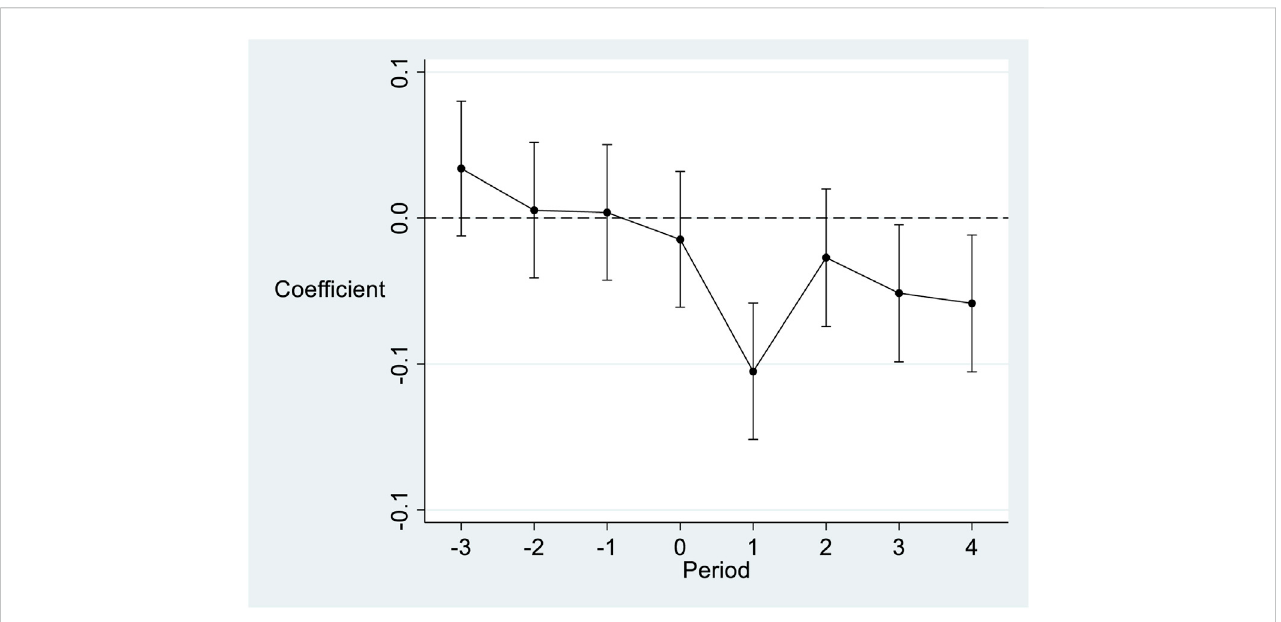
ResultsofParallelTrendTest.The X -axisdenotesthewindowperiodforAAQSimplementation.The Y -axisrepresentstheregressioncoef fi cientofAAQS implementation. The year before AAQS is implemented as the base